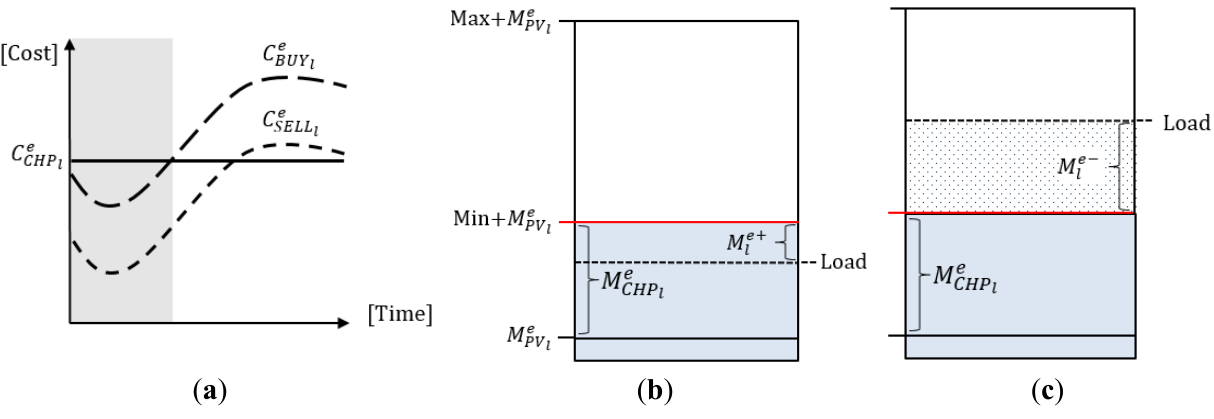
(cid:3032) (cid:2887)(cid:2892)(cid:2900) (cid:3287)